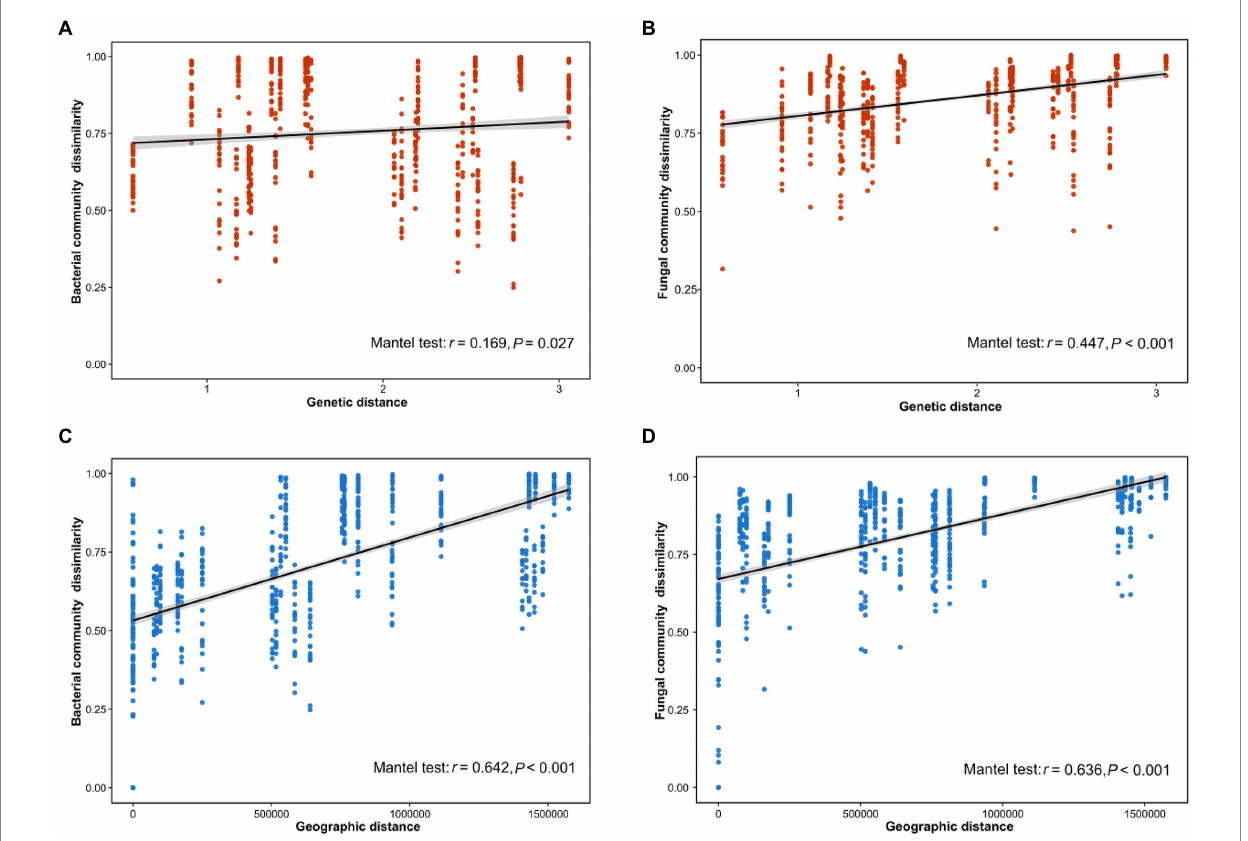
FIGURE 2 Correlation between the dissimilarity of the bacterial (A) and fungal (B) communities and host genetic distance. The distance-decay relationships between dissimilarity of the bacterial (C) and fungal (D) communities and geographical distance.